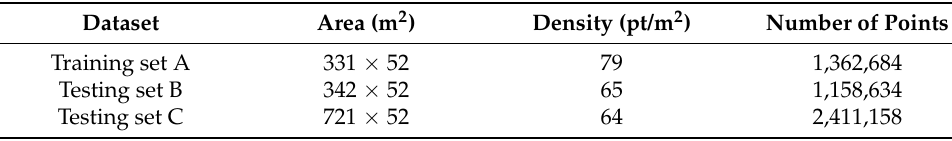
Table 2. Information for the experimental